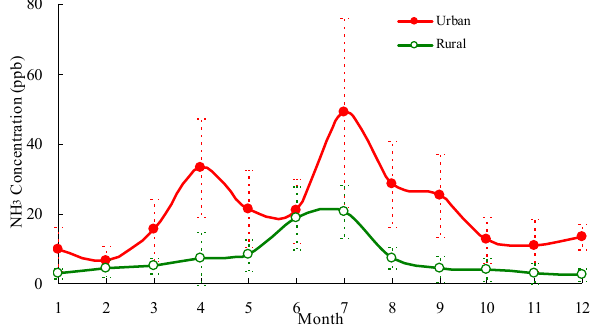
Fig. 4. The statistics of monthly mean concentrations of NH 3 dur- ing the sampling period at the two observation sites in Fig.4. The statistics of monthly mean concentrations of NH 3 during the sampling period at the two observation sites in Beijing.